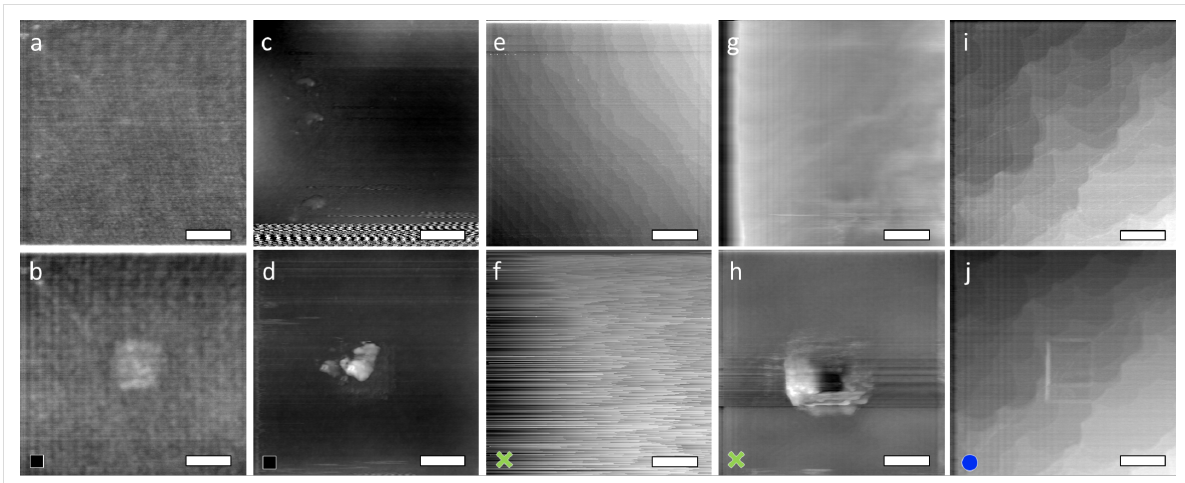
Figure 5: Surface topography of the same area before (upper row) and after (lower row) the friction sequences were recorded in the center of the frames. Scale bars: 200 nm. a, b) Control experiment with an intact Au/Si tip on an oxidized Si(100) surface. Eleven frames were scanned in the center of the scan. The square in the center was elevated by 10 pm. c, d) Activated Au/Si tip on oxidized Si(100). The onset of the tribochemical reac- tion is revealed in panel c) as intermittent increase in friction causing distortion of the topography measurement. A feature with a height of about 10 nm had evolved in the central area after scanning 21 frames in the image center (panel d)). e, f) Intact SiO x /Si tip on reactive Si(100). Monatomic steps were observed in panel e); after scanning four frames the topography measurement became hampered by high adhesive friction (panel f)). g, h) Activated SiO x /Si tip on Au (111). After 15 scans in the center, the topography had changed significantly. The height of the pile-up around the square depression is about 5.8 nm (panel h)). i, j) Intact Au/Si tip sliding on Au(111); despite low normal forces applied and low friction force measured, scan- ning ten frames in the center resulted in topographical changes. The scanning area had been offset after five scans; therefore two overlapping squares can be distinguished. The height of the pile-up at the left edge of the squares is about 1.15 nm (panel